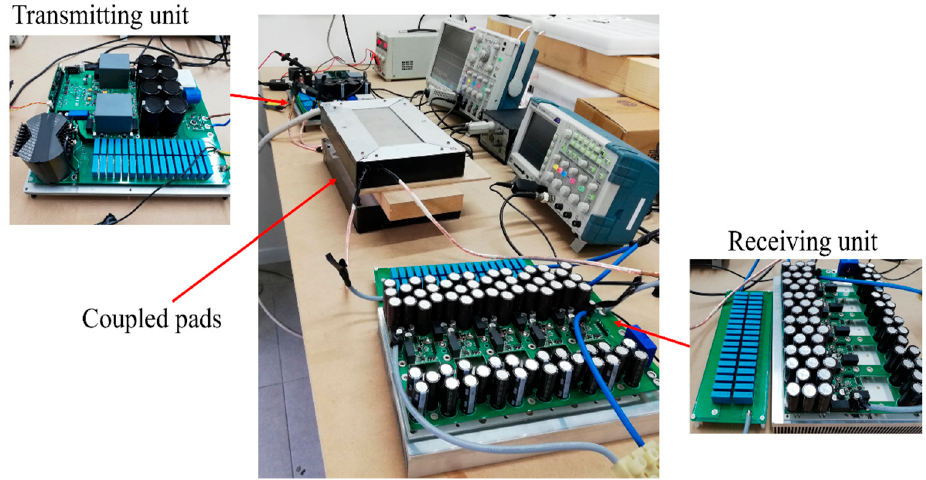
Figure 13. Picture of the layout of the IPT system during the experimental test. The three main components of the system, namely the transmitting unit (rectifier + inverter + compensating networks), the couple pads and the receiving unit (compensating network + rectifier + DC/DC converter) are shown in the insets.